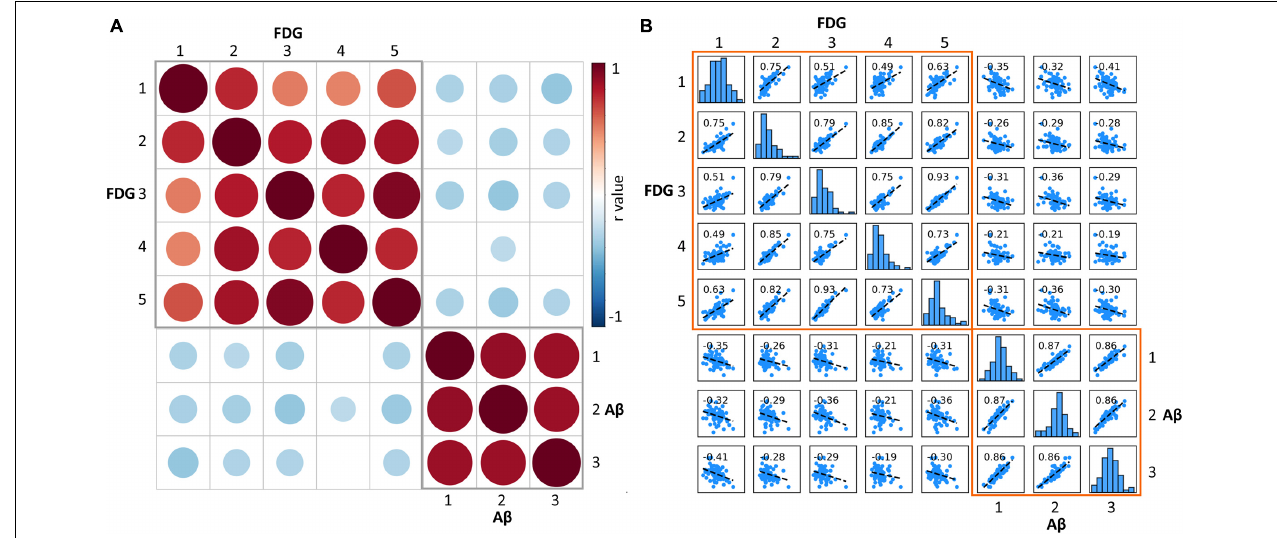
FIGURE 5 | (A) Matrix of Pearson correlation coefficients between amyloid deposition and glucose metabolism for each category. The red circle represents significant positive correlation, the blue circle represents significant negative correlation, and the empty grid represents insignificant correlation. The size of the circle represents the size of the correlation coefficient. (B) Scatterplot matrix shows the correlation of each A β -FDG category pair. The diagonal-bar graph represents the SUVR value distribution of each category. FDG, fluorodeoxyglucose; SUVR, standardized uptake value ratio.